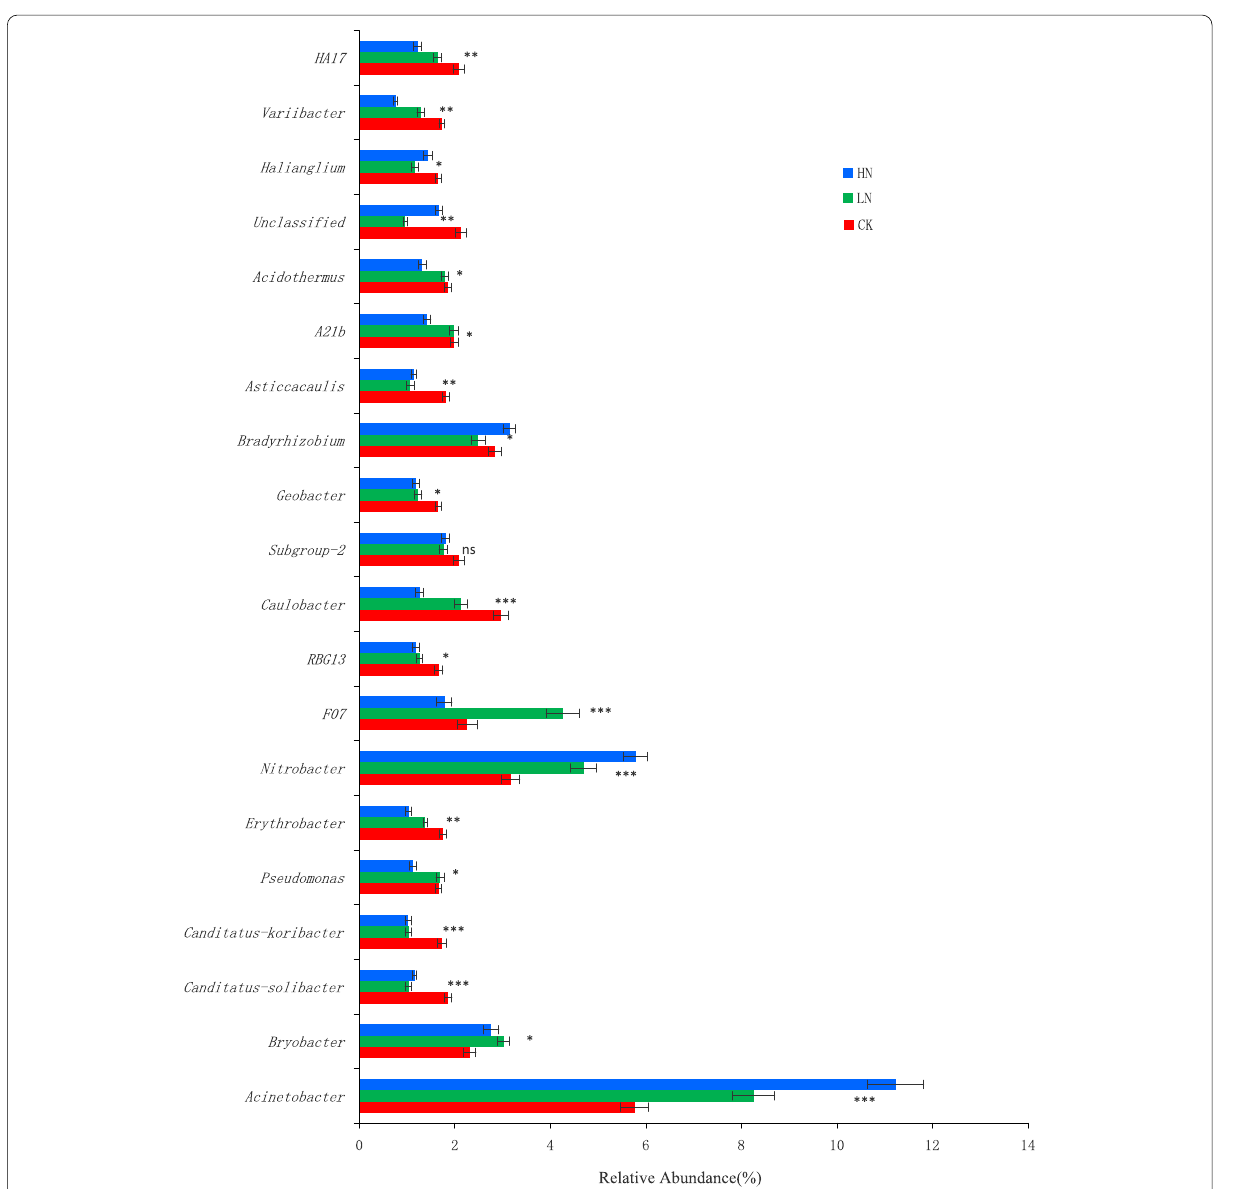
Fig. 3 Changes in the genus‑level composition of soil bacteria communities under different nitrogen deposition